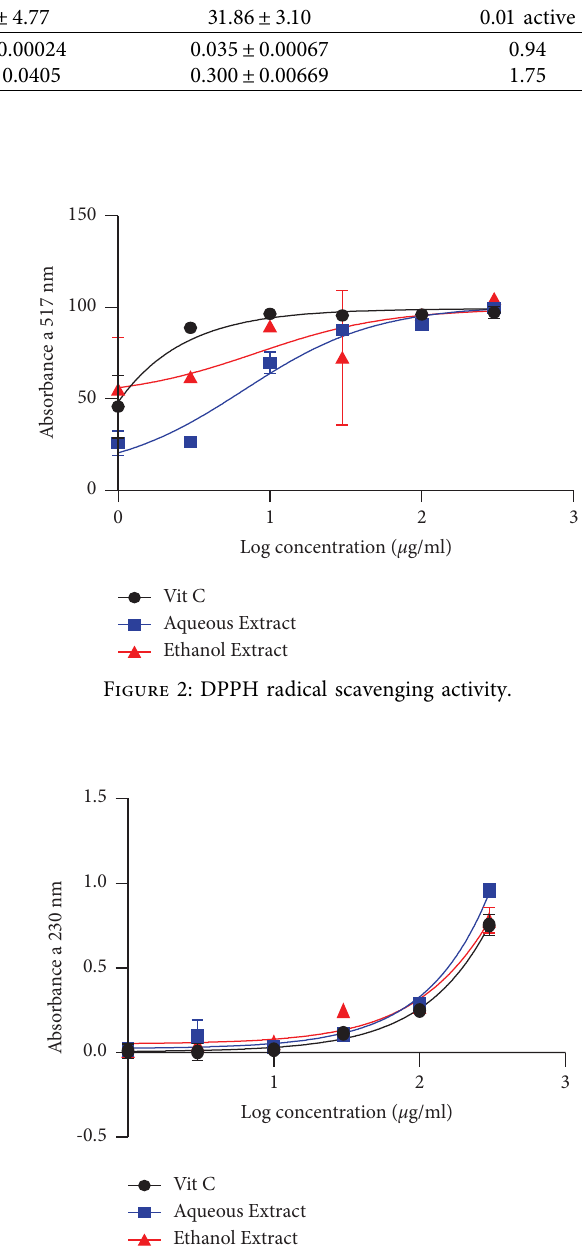
Figure 3: H 2 O 2 radical scavenging